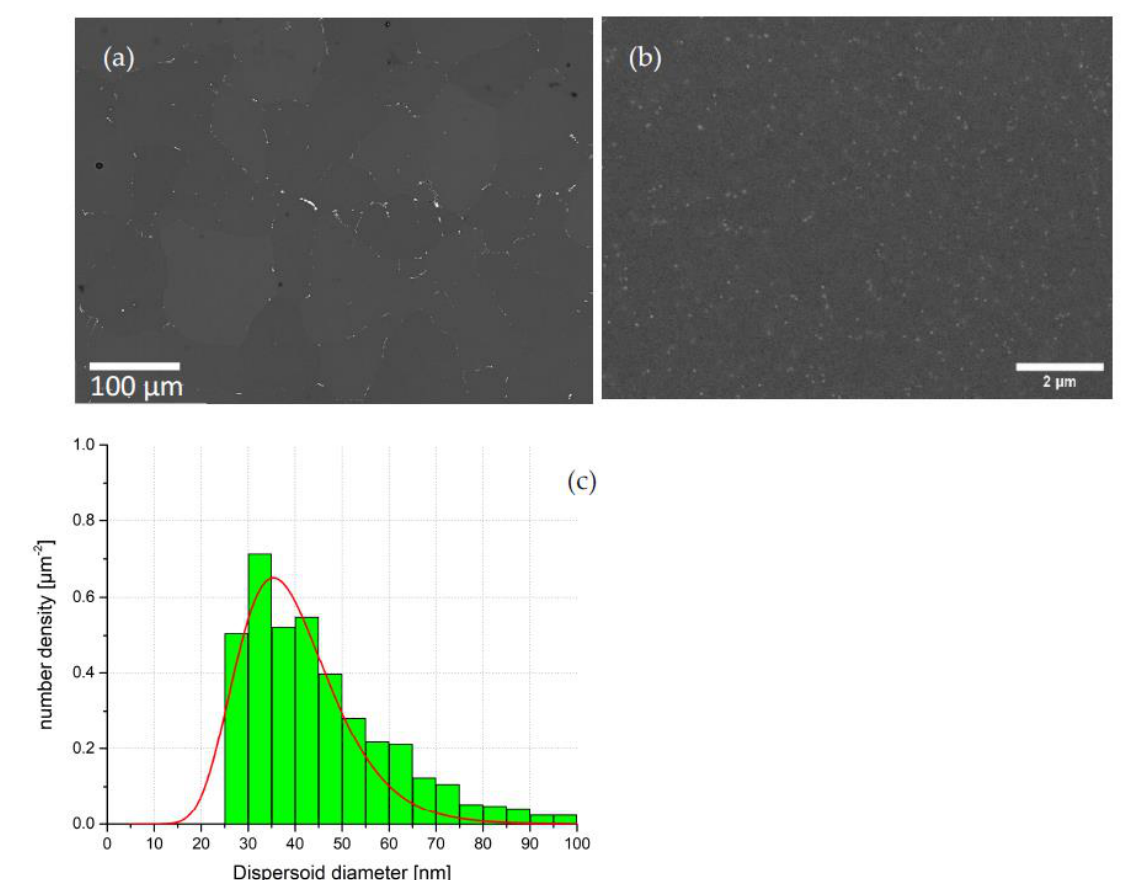
Figure 4. ( a ) SEM micrograph of the homogenized and water quenched sample #13. ( b ) SEM image in larger magnification showing the dispersoid distribution within a grain from ( a ). ( c ) Size distribution of dispersoids in sample #13 calculated from the SEM results.